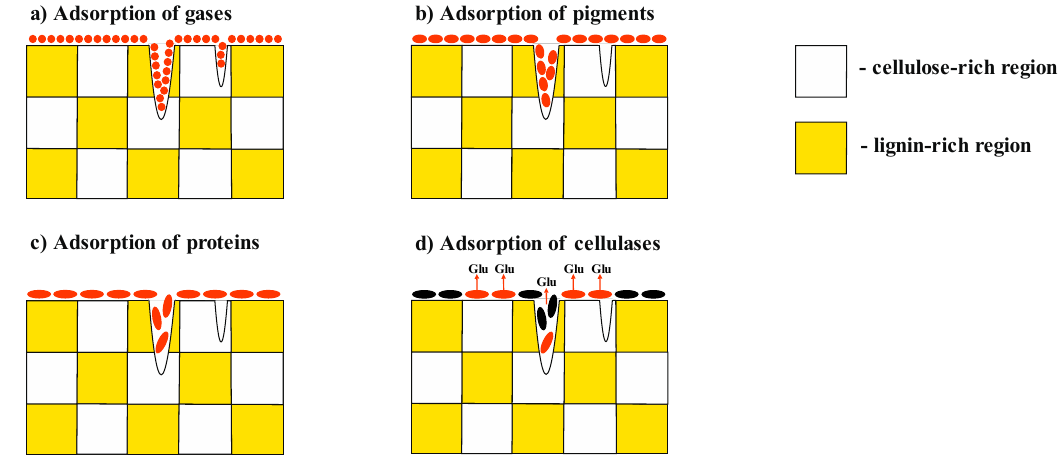
Figure 1. Scheme of sorption of low-molecular-weight gases ( a ), pigments ( b ), proteins ( c ), and cellulases ( d ) onto the surface of lignocellulosic biomass.